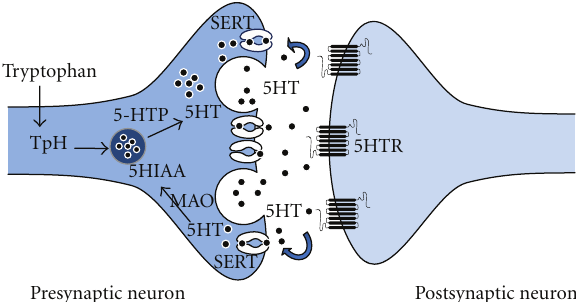
Figure 1: Schematic diagram depicting the major pathways involved in the synthesis, release, re-uptake and metabolism of serotonin in serotonergic neurons. Components of the figure have been modified from Motifolio. TpH: tryptophan hydroxylase;